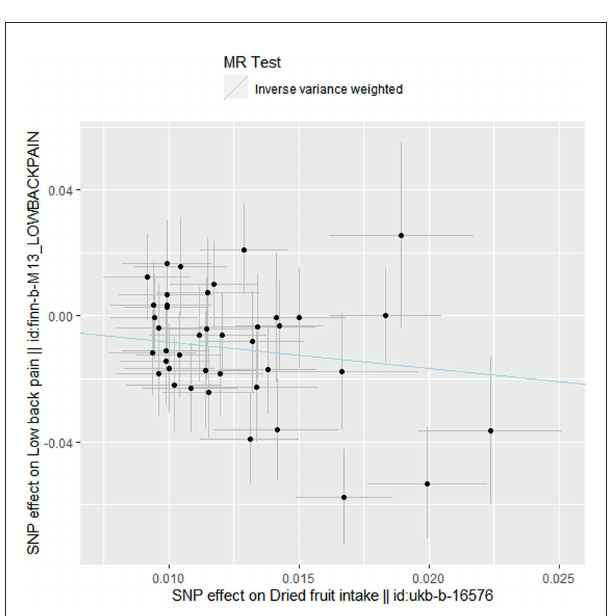
FIGURE1 Scatter plot showing Mendelian randomization effect estimates of dried fruit intake over low back pain. Each variant-low back pain association is plotted against variant-dried fruit intake association, and the corresponding Mendelian randomization estimate for inverse variance weighted is